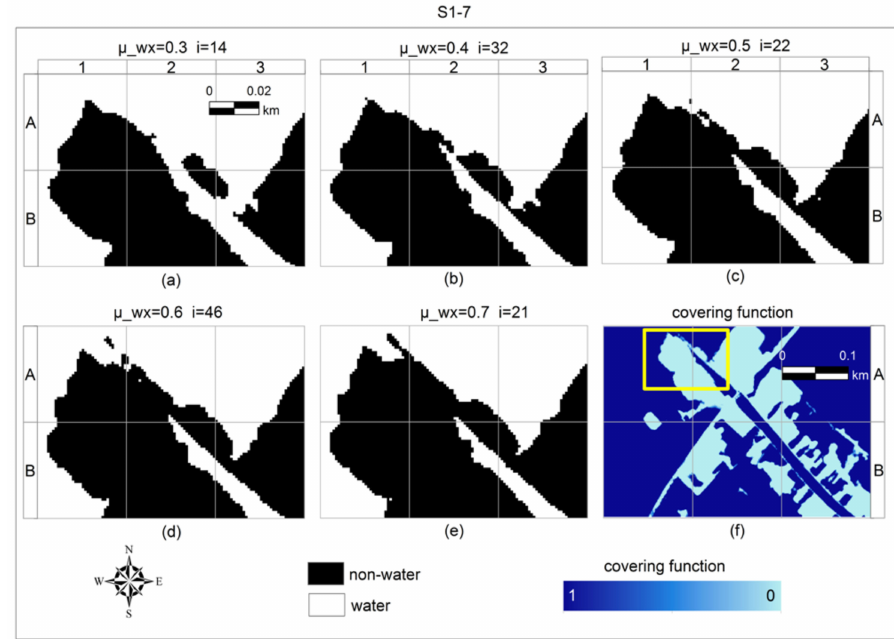
Figure 9. Samples of the random sets with various extents and their covering function. ( a – e ) Samples are at µ wx = 0.3–0.7. Pixels in white indicate the water area and pixels in black indicate the non-water area. ( f ) The related covering functions, where 0 indicates a low probability and 1 indicates a high probability to be covered by the random sets. Various extents of focal elements at each binary map can be seen when zooming into the yellow rectangle